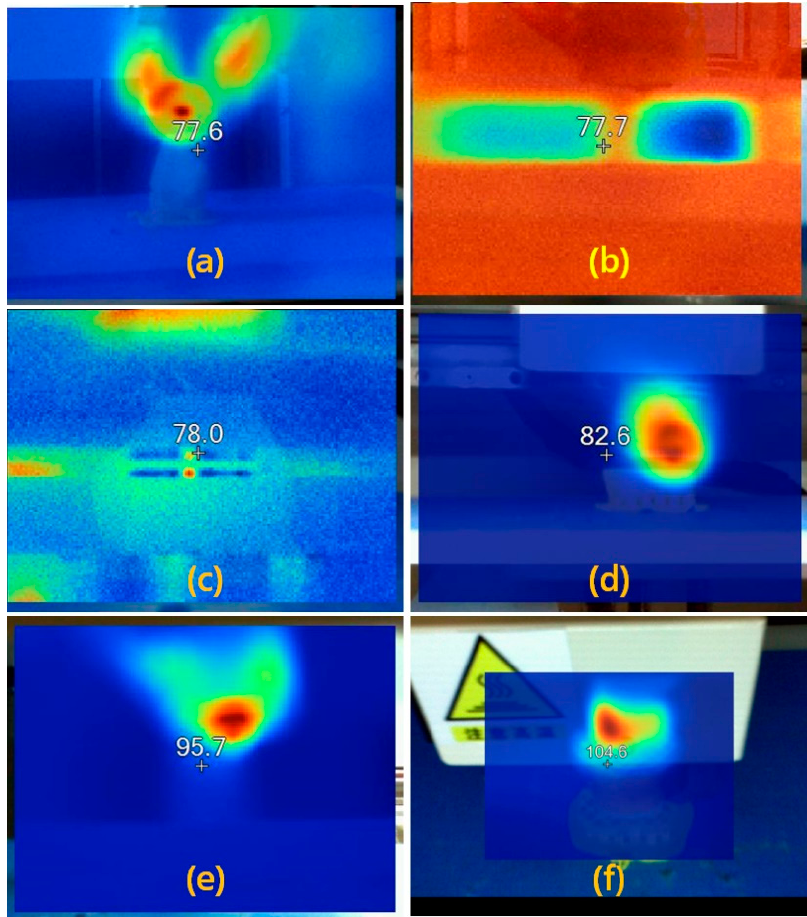
Figure 4. Thermographs during temperature rise process. The incremental temperature T b of ( a – f ) are, respectively, 77.6 °C, 77.7 °C, 78.0 °C, 82.6 °C, 95.7 °C, 104.6 °C.